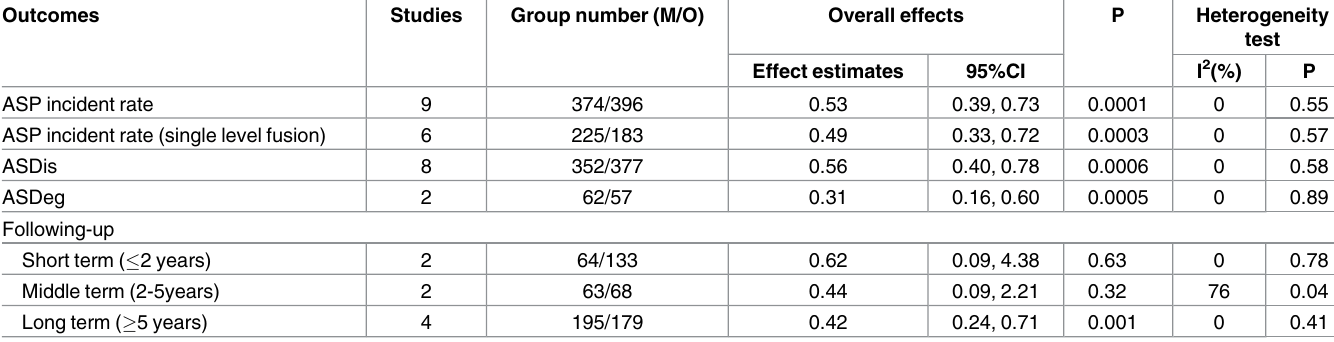
Table 5. The results of different meta-analysis outcomes for MIS-group and